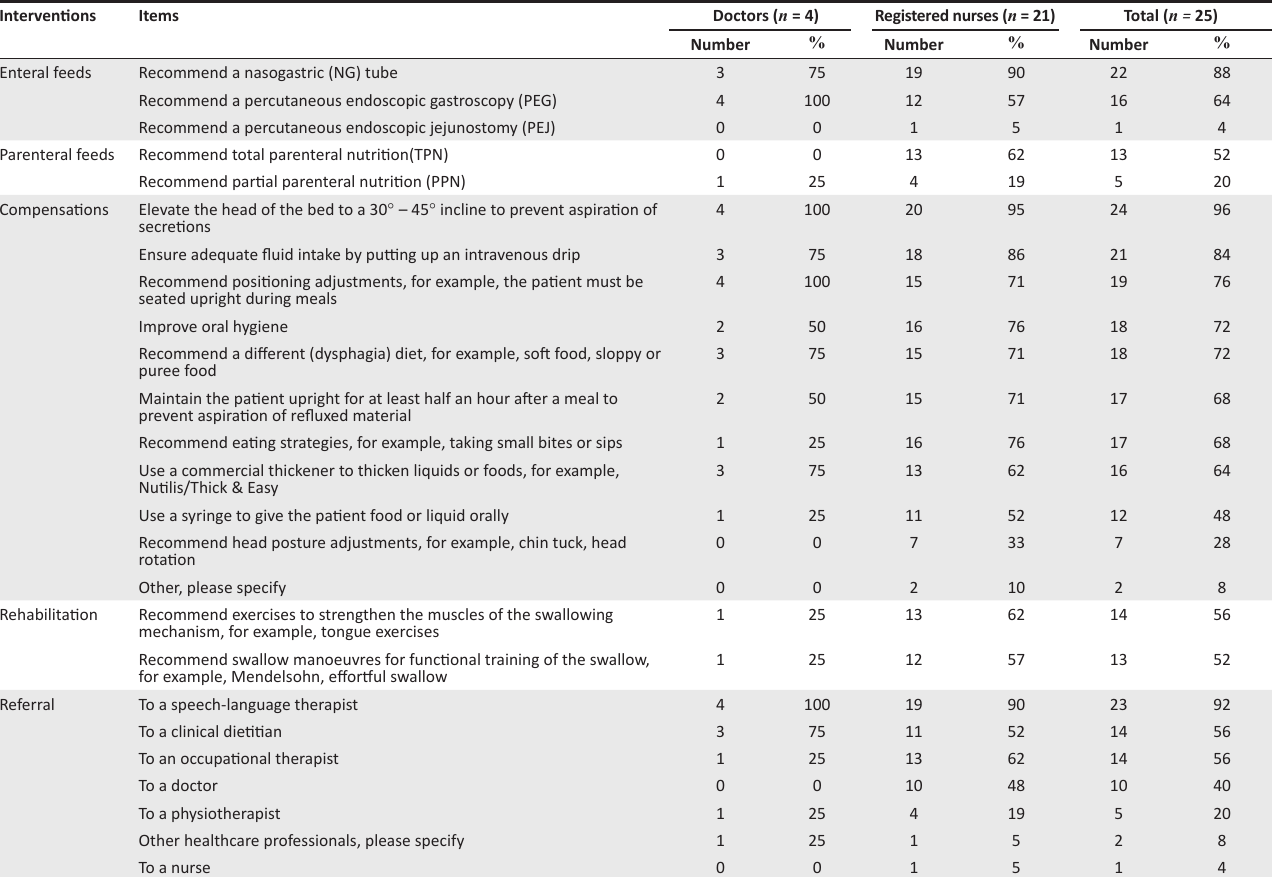
TABLE 3: Dysphagia intervention. Interventions